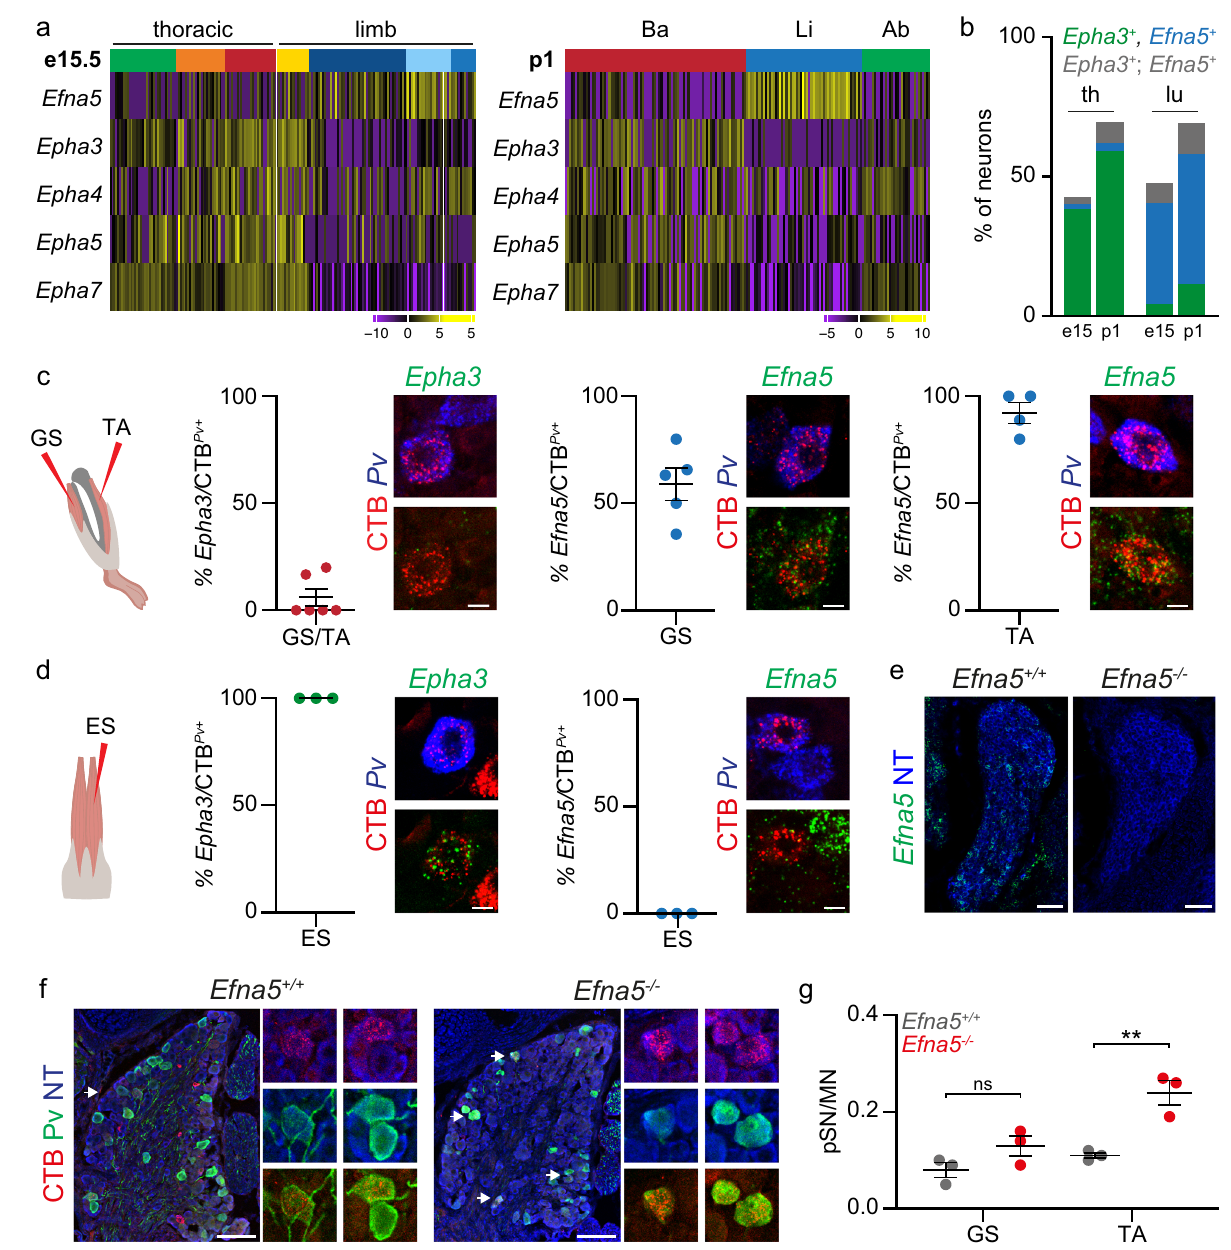
Fig. 5 | Elimination of ephrin-A5 function erodes the speci fi city of muscle connectivity. a Gene expression analysis (logcounts) of ephrin-A/EphA family members differentially expressed in proprioceptor clusters identi fi ed at e15.5 (thoracic origin: green, orange, red; lumbar origin: yellow, dark blue, light blue, and blue)andp1(back:red;hindlimb:blue;abdominal:green). b Percentage of Pv + or tdTomato + sensory neurons expressing Epha3 (green), Efna5 (blue) or Epha3; Efna5 (gray) at thoracic and lumbar levels in either e15.5 or p1 Pv Cre ; Ai14 mice (mean±SEM, n ≥ 2animals). c RepresentativesmFISHimagesandquanti fi cationof Epha3 (left)and Efna5 (center/right)expressionin Pv + sensoryneuronsretrogradely labeledafterCTBinjectioningastrocnemius(GS),andtibialisanterior(TA)muscles ofp1wild-typemice(mean±SEM, n ≥ 4animals).Scalebar:10 µ m. d Representative